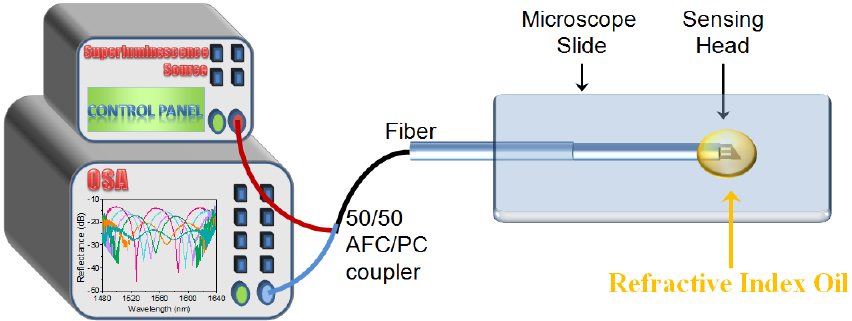
Figure 2. Experimental set-up for Cargille refractive index liquids measurements.